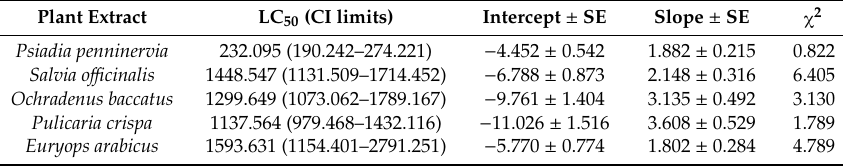
Table 4. Values of LC 50 ( µ g / mL) for extracts from five medicinal plant species against 2nd larval instar of Chrysoperla carnea.